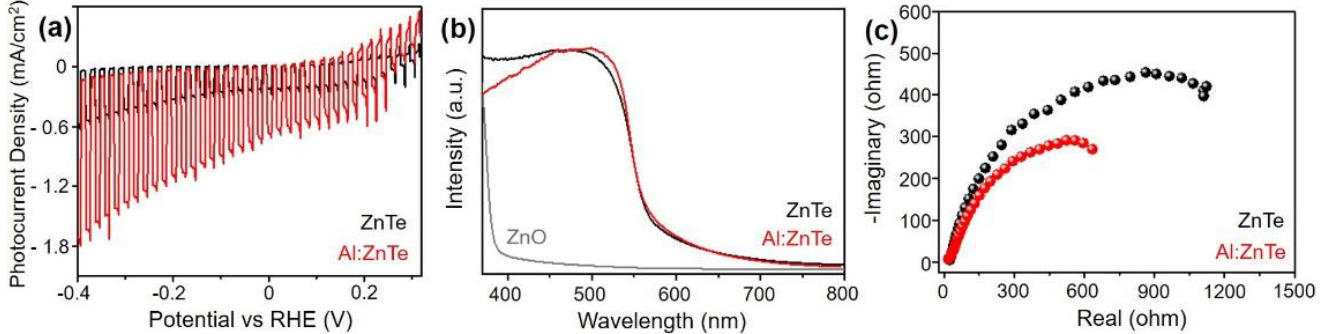
Figure 3. ( a ) J-V plot (scan rate of 5 mV/s), ( b ) absorbance, and ( c ) Nyquist plot of Al:ZnTe and ZnTe. All photoelectrochemical measurements were performed in 0.5 M CO 2 -saturated KHCO 3 under simulated solar illumination (AM 1.5 G, 100 mW/cm 2 ). The Nyquist plots were prepared by measuring electrochemical impedance spectroscopy at − 0.11 V RHE .